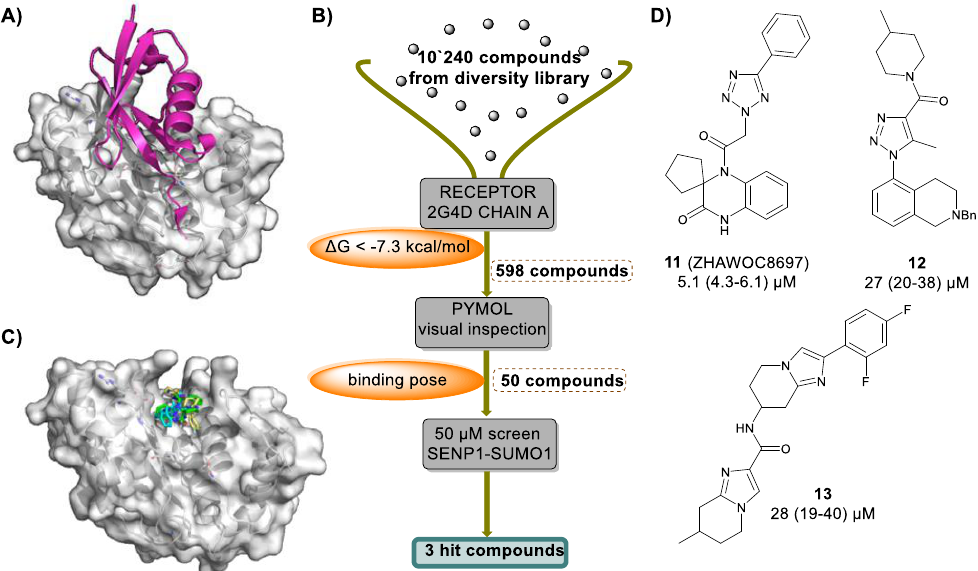
Figure 2. ( A ) X-ray crystal structure of SUMO1 (cartoon: magenta)-SENP1 (PDB code: 2G4D); ( B ) Virtual screening process against the protein-protein interaction between SENP1 and SUMO1; ( D ) The hit structures 11 (ZHAWOC8697), 12 and 13 are shown with the corresponding in vitro measured IC 50 value and the proposed binding mode ( C ).